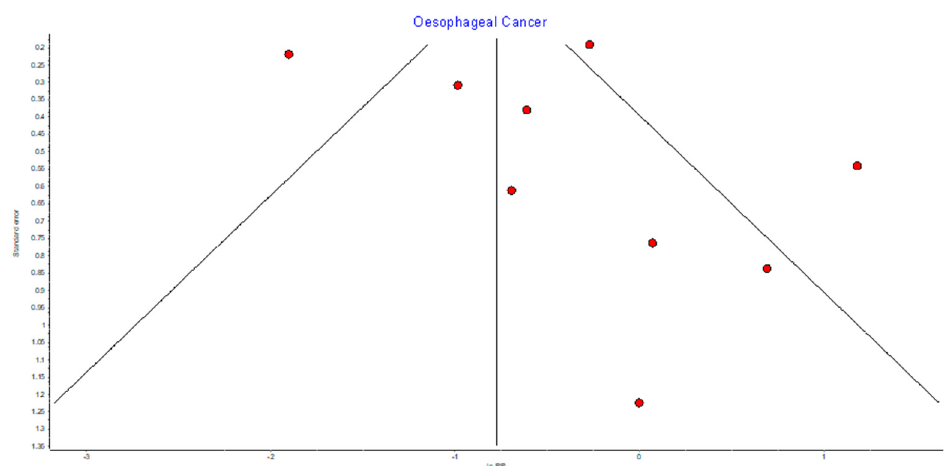
38 of 51 Figure A11. CRC female random e ff ects model funnel plot. Table A11. CRC female random e ff ects model sensitivity analysis. Excluded Study